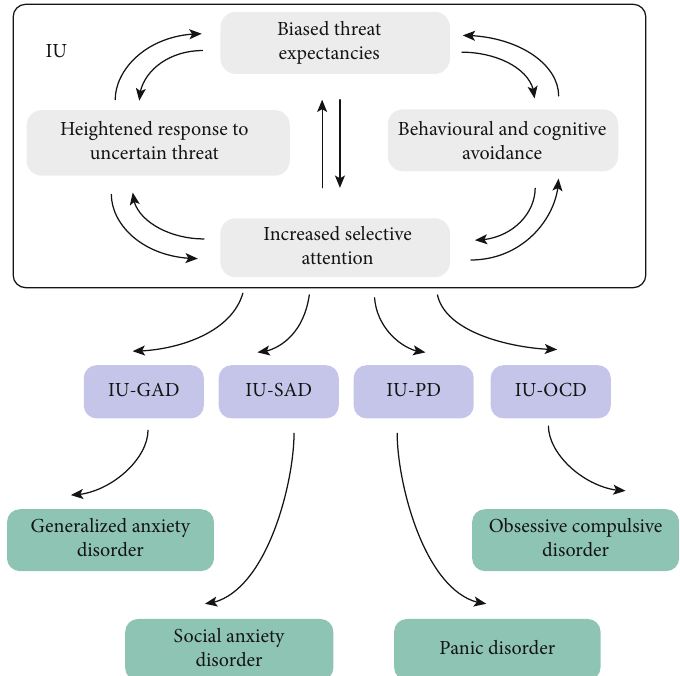
Figure 1: This fi gure demonstrates the cognitive model of IU across anxiety disorders raised by us. The IU construct consists of multiple factors and the interaction between them. In a process shown in the fi gure, di ff erent